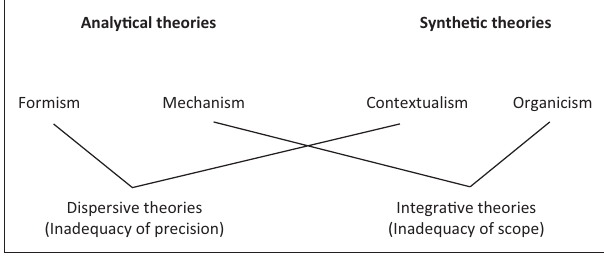
FIGURE 1: A schematic summary of world